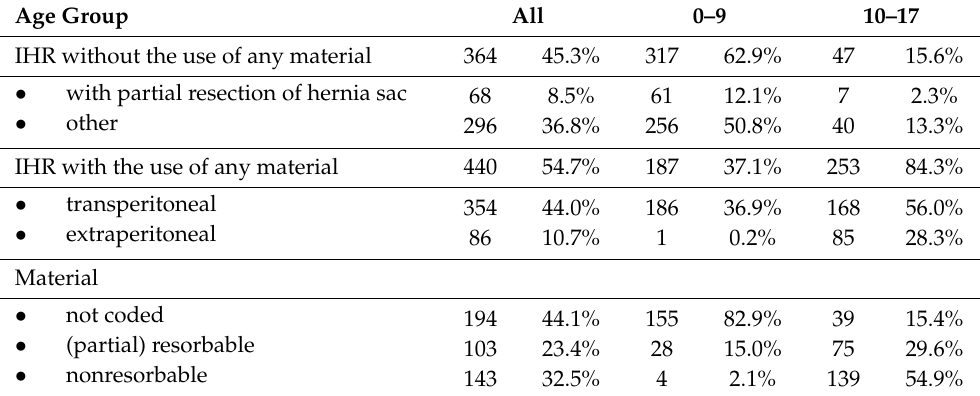
Table 3. Technique of laparoscopic inguinal hernia repair (IHR).